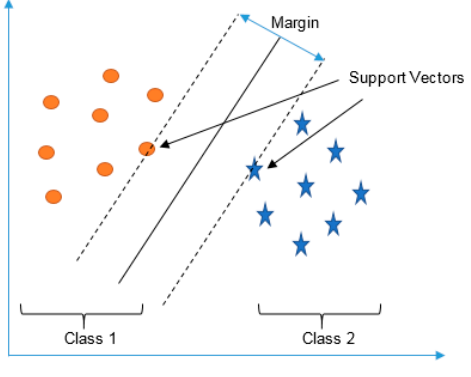
Figure 8. A SVM structure.